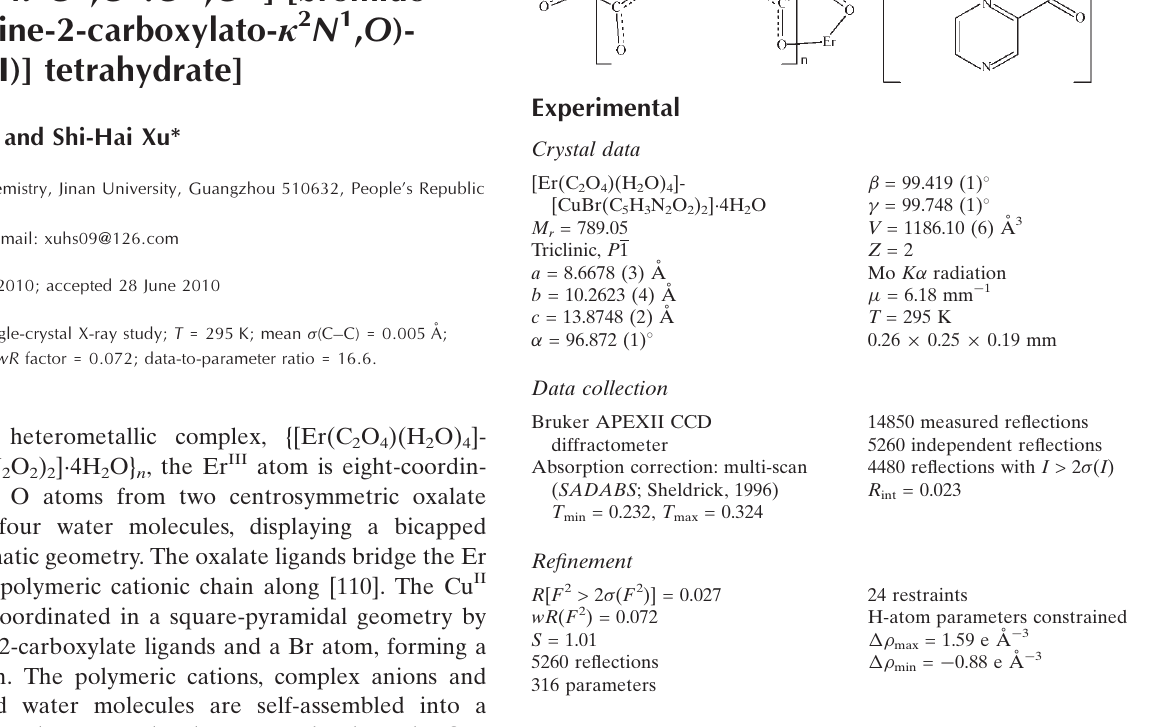
14850 measured reflections 5260 independent reflections 4480 reflections with I > 2 (cid:2) ( I ) R 24 restraints H-atom parameters constrained